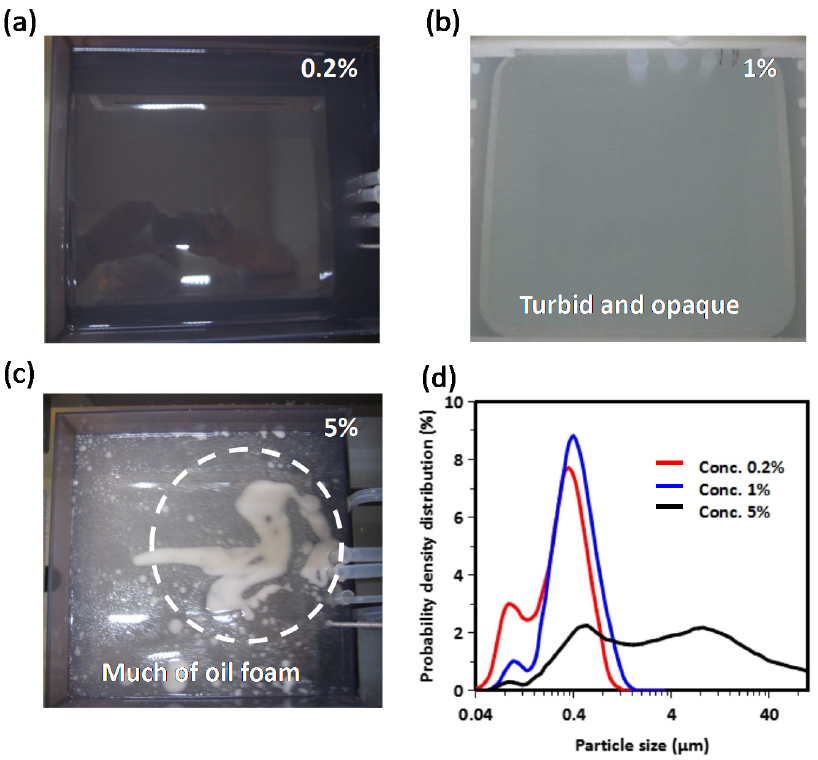
Figure 3. Photos from the top of the solution of the additive at concentrations ( a ) 0.2%, ( b ) 1%, ( c ) 5%, and ( d ) the distribution of the additive dispersed particles with the stirred rate of 15 L/min.